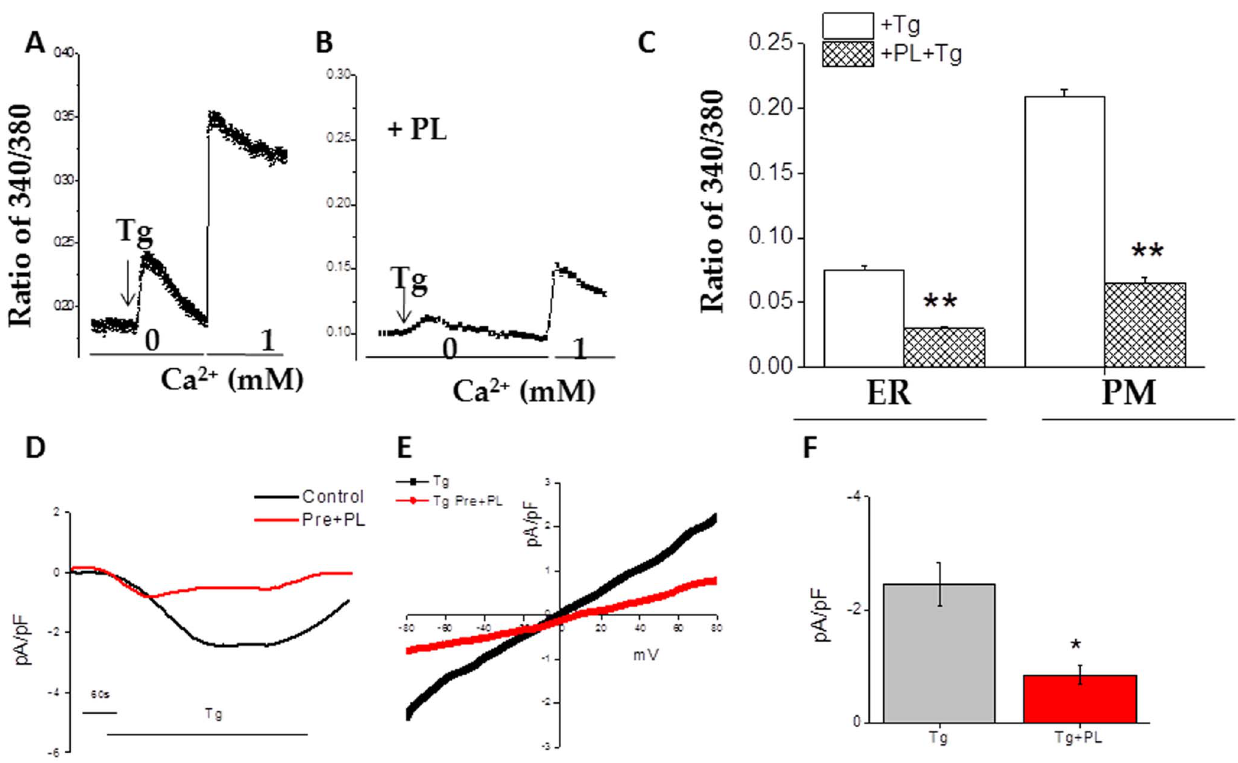
Figure 7. Helminth antigens inhibit Tg induced Ca 2 + release and Ca 2 + entry. Fura 2 fluorescence measurements in J774 cells. Cells were pulsed with medium alone, Tg at 1 uM, or pretreat PL at 25 ug/ml for 20 mins before the addition of LPS to the medium. Analog plots of the fluorescence ratio (340/380) from an average of 0- 50 cells are shown in (A) and (B). (C) The bar graph indicates the average data on calcium release (first peak) and calcium entry (second peak) under these conditions. ** indicate significance (p= , 0.01). (D) Inward currents were induced upon store depletion at 2 80 mV in control and PL treated cells Respectively IV curves under these conditions are shown in (E). Average (8–10 recordings current intensity at 2 80 mV are shown in (F). * indicate significance (p= , 0.05).